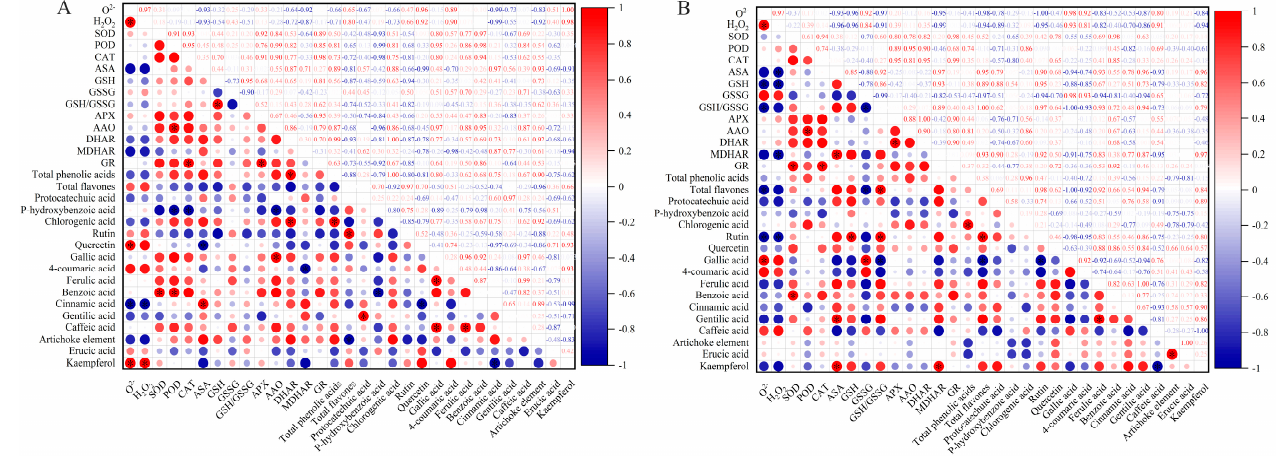
Figure 11. Pearson correlation analysis of exogenous proline effect on phenolic compounds and ascorbic acid (ASA)-glutathione (GSH) cycle in celery under salt stress. * represents significant correlations at p < 0.05. After planting the 35-day-old seedlings for 7 days, they were treated with 0.3 mM proline solution for 7 days, after which they were watered with 100 mM NaCl solution thrice every 3 days. ( A ) Celery leaves. ( B ) Celery petioles.